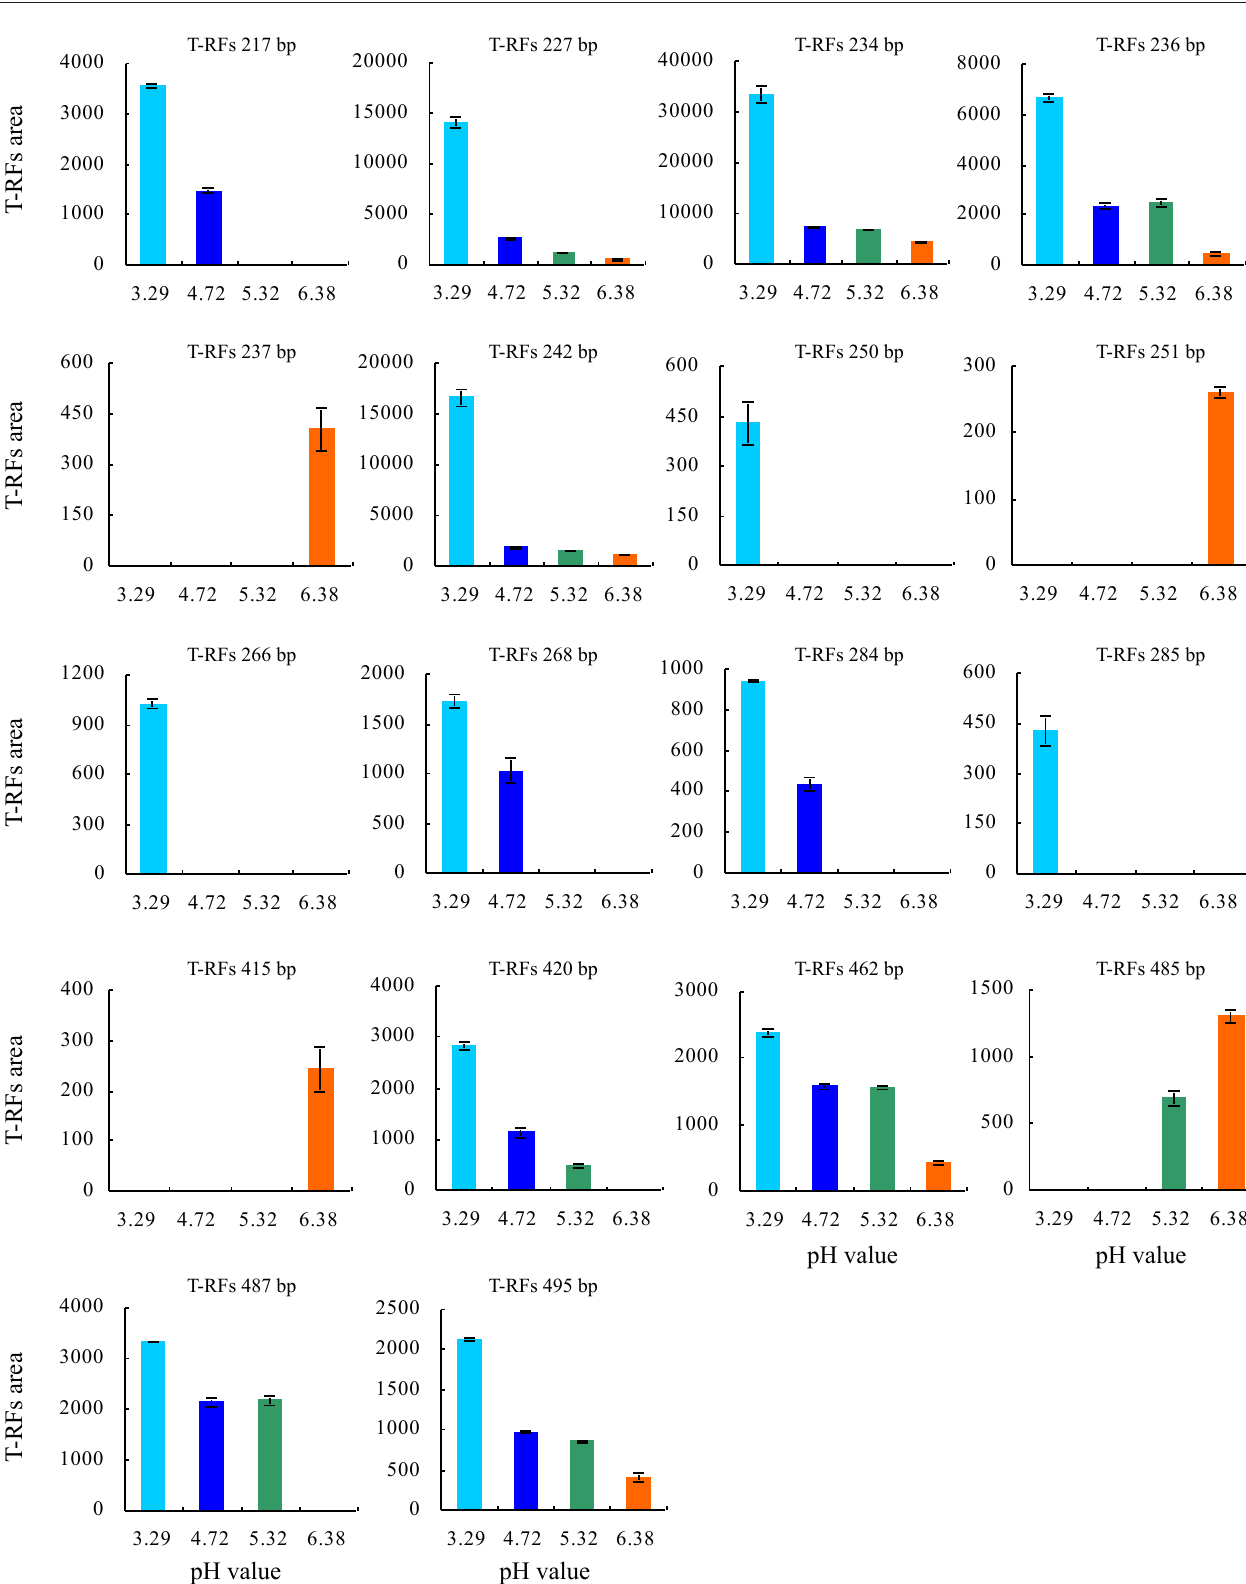
Fig. S6: T-RFs fragment area of fungi in rhizosphere soil of tea tree with different pH